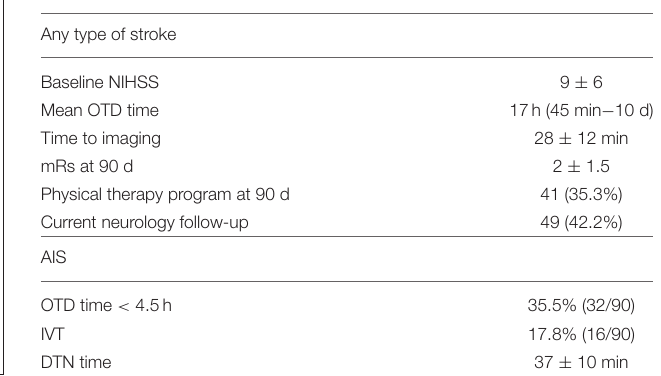
TABLE 2 | Patient characteristics at admission and outcome for any type of stroke and for patients with AIS subtype.